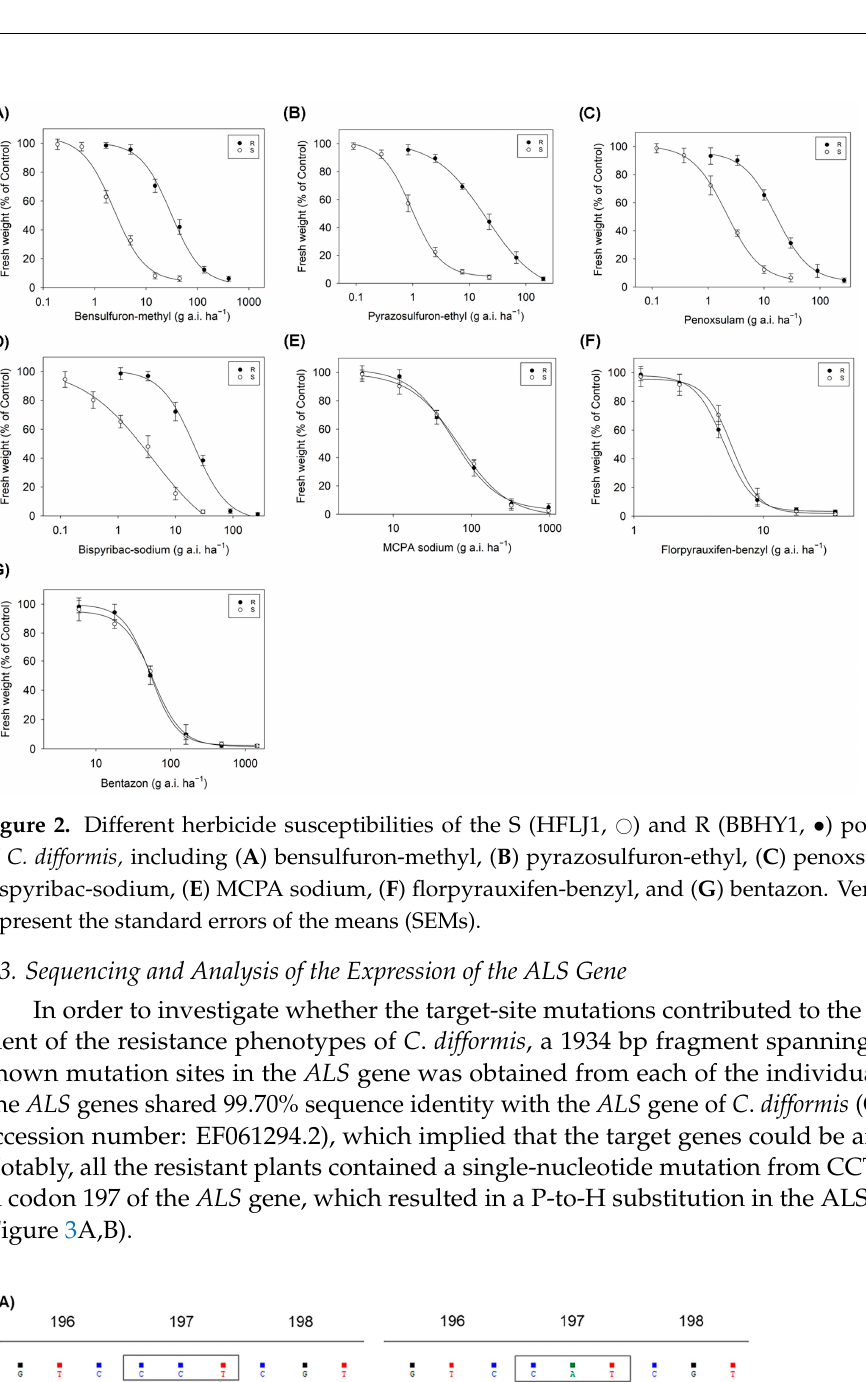
Figure 4. ALS gene expression levels relative to control at 0, 12, and 24 h after bensulfuron-methyl administration in C. di ff ormis plants. Di ff erent le tt ers represent a signi fi cant di ff erence ( p < 0.05). No obvious di ff erence (fold change < 2, p > 0.05) was detected in the ALS expression between the R (BBHY1) and S (HFLJ1) plants. 3.4. E ff ects of Malathion and Pretreatment with NBD-Cl on Bensulfuron-Methyl Resistance Analysis of the whole-plant response of the R and S populations treated with mala- thion or NBD-Cl alone revealed that there was no obvious di ff erence in plant mortality relative to that of the untreated control. The results demonstrated that there was no sig- ni fi cant di ff erence in the GR 50 of the R and S populations following treatment with ben- sulfuron-methyl plus malathion or pretreatment with NBD-Cl. The fi ndings indicated that bensulfuron-methyl resistance in the R population was not a tt ributed to metabolic en- hancement mediated via the CYP450 or GST enzymes (Table 4, Figure 5). Table 4. Parameters of the log-logistic equation (1) a for the whole-plant dose-response of the cytochrome P450 inhibitor (malathion) and GST inhibitor (NBD-Cl) on C. di ff ormis re- sistance to bensulfuron-methyl Herbicide